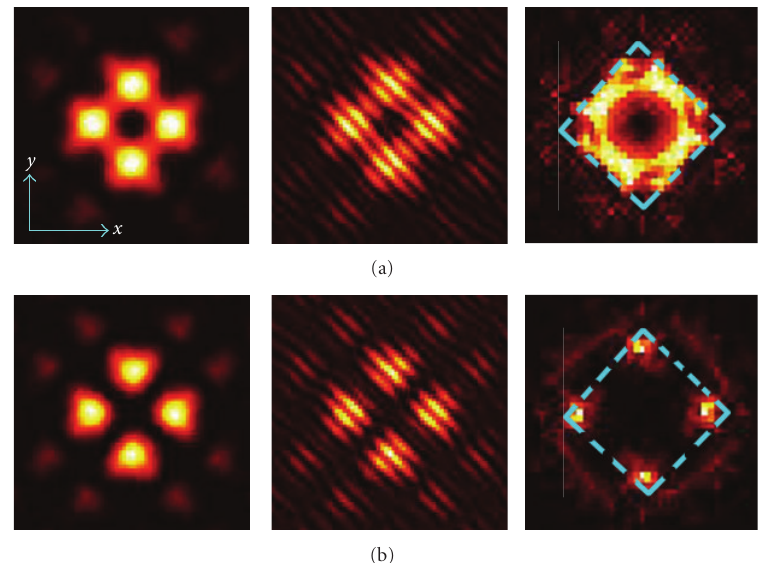
Figure 3: Simulation results of singly charged (a) and doubly charged (b) vortex beams propagating to a longer distance of 40 mm. Shown are the output transverse ( x - y ) intensity pattern (left), its interferogram with a tilted plane wave (middle), and its k -space spectrum (right) in both (a) and (b). Notice that the vortex singularity maintains in (a) but disappears in